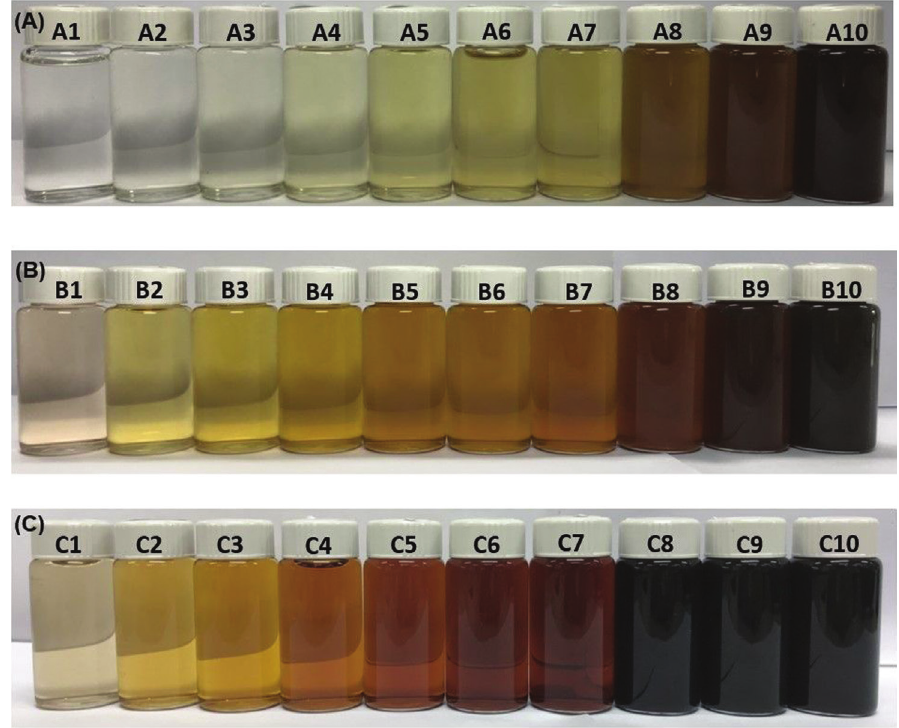
Figure 4: Changing of color intensity of AgNPs aqueous solution reduced by LHE before reduction process takes place (a), after overnight reduction (b), and after overnight reduction followed by heating at 90°C for 1 h (c). Numbers 1 to 10 represent the employed concentration range of LHE: 0.003 wt%, 0.006 wt%, 0.01 wt%, 0.025 wt%, 0.05 wt%, 0.08 wt%, 0.1 wt%, 0.3 wt%, 0.5 wt% and 1.0